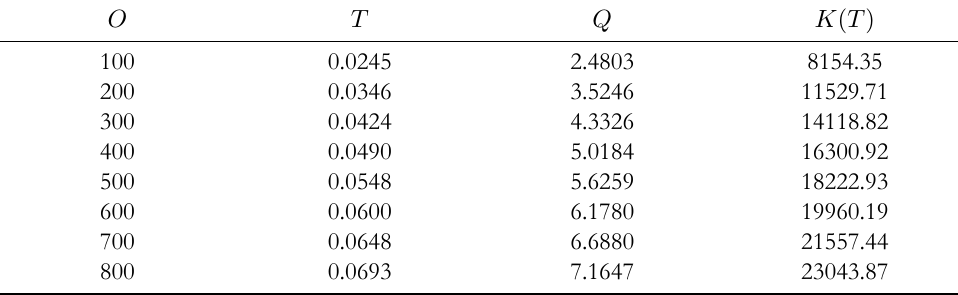
Table 1: Variation in T; Q & K ( T ) with ordering Cost ( O )